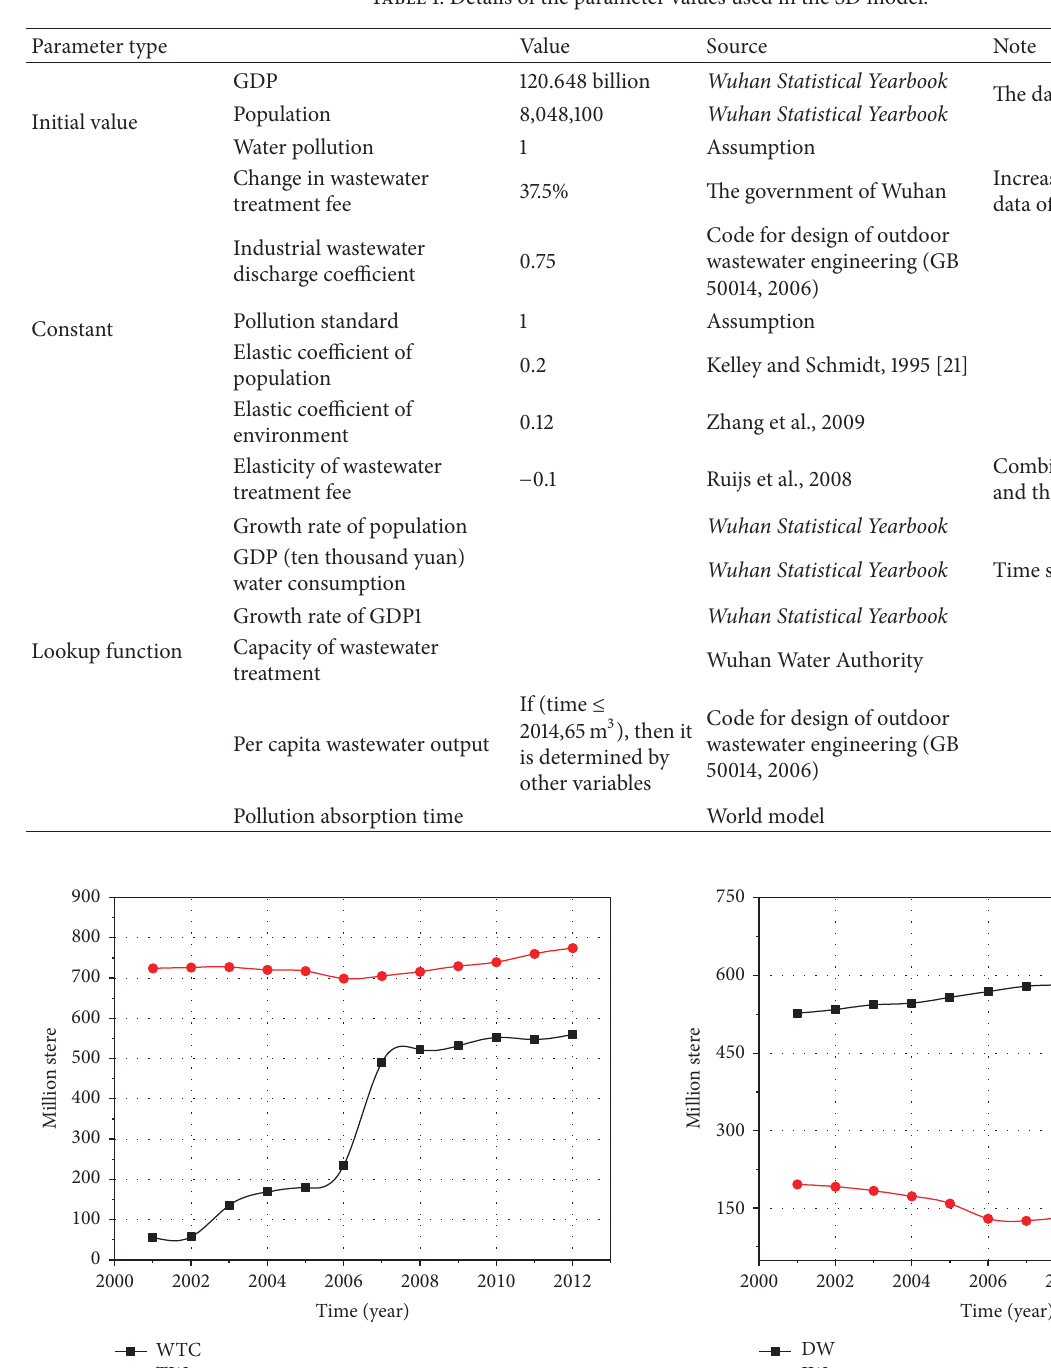
Table 1: Details of the parameter values used in the SD model.